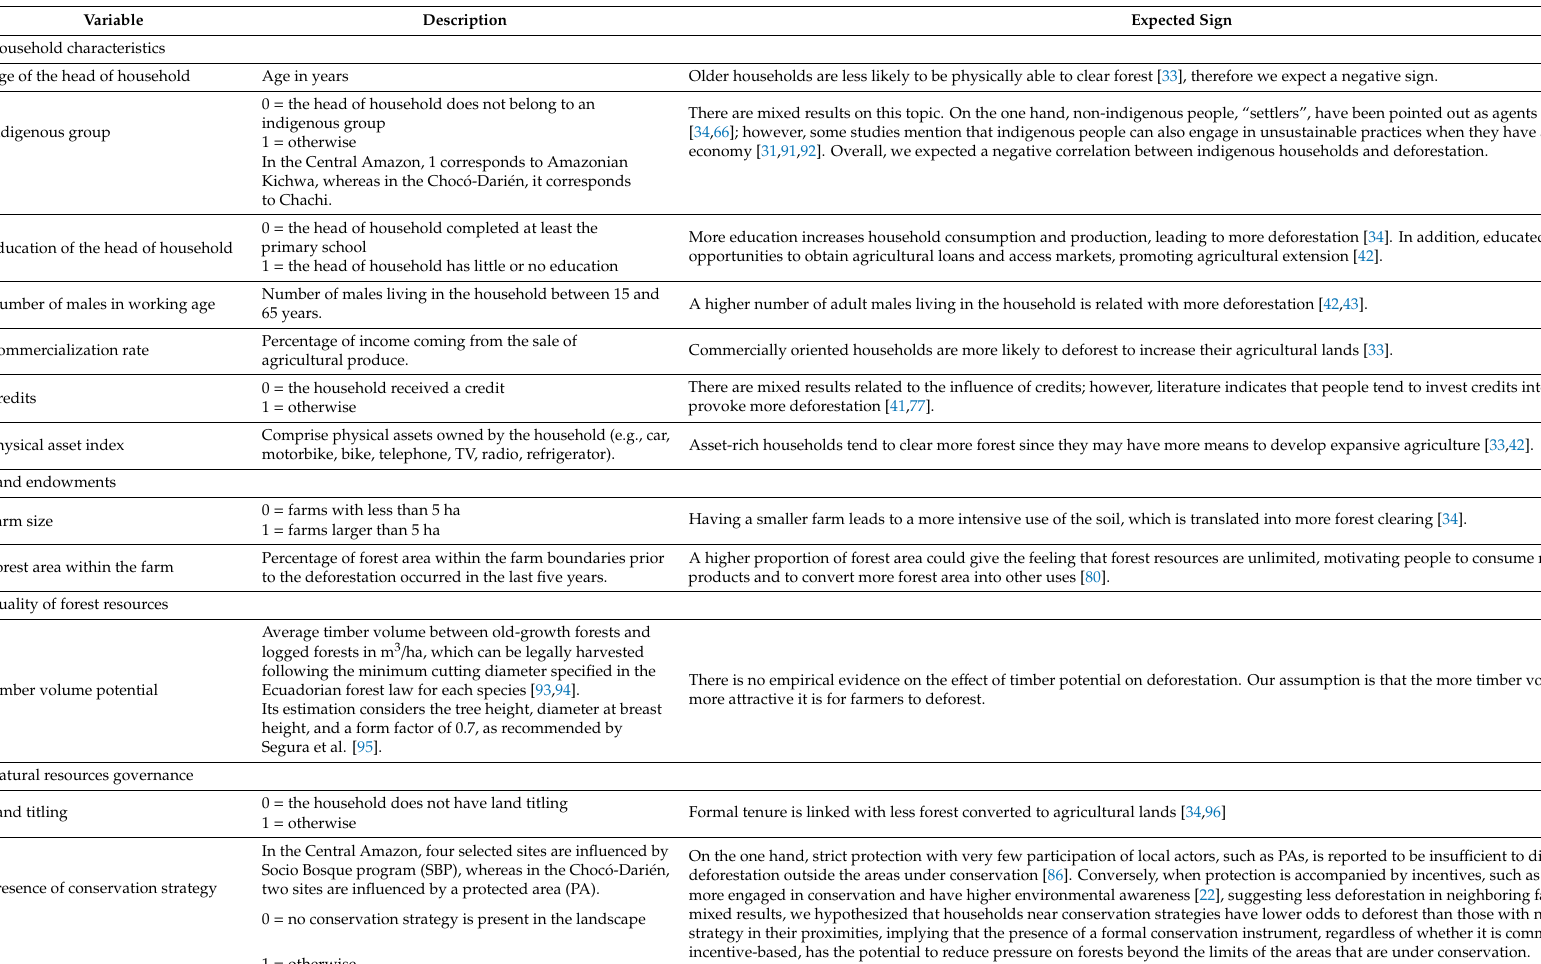
Table 1. Predictors selected for the logit model to evaluate household deforestation